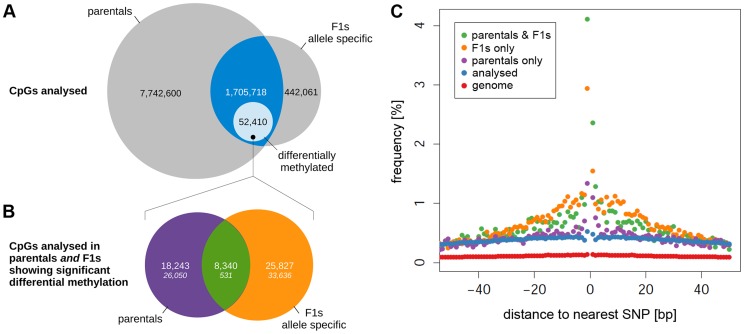
Comparison of differential methylation in parental strains and allele-specific methylation in F1 crosses.(A) Venn diagram showing the number of CpGs tested for differential methylation in the parental strains ONLY or for allele-specific methylation ONLY (grey areas) and the fraction of CpGs tested for BOTH (intersection, blue). The light blue area shows the number of CpGs significantly differentially methylated between the parentals AND/OR showing allele-specific methylation. Areas are not proportional. CpGs on the X chromosome and the mitochondrial chromosome have been excluded. (B) Overlap of differential methylation between the parental strains and allele specific methylation in the F1s. In total, 52,410 out of the 1,705,718 CpG dinucleotides analysed in both the parentals and the F1s (intersection, blue in (A)) showed significant differential methylation. The Venn diagram shows the fraction of CpGs that were differentially methylated between the parents ONLY (purple), between the alleles in the F1s ONLY (orange) or in BOTH (green). The theoretical distribution of frequencies assuming random overlap between the parental and the F1 data sets are shown in italics (X2 = 135276.2, P<4.9×10−324). The overlap of the two sets is >15 fold higher than expected by chance. (C) Frequency of CpGs with a SNP within 50 base pairs for CpGs showing differential methylation between the parentals only (purple), the F1 alleles only (orange) and both (green) compared to all CpGs analysed in the parentals and the F1s (blue) and the whole genome (red).